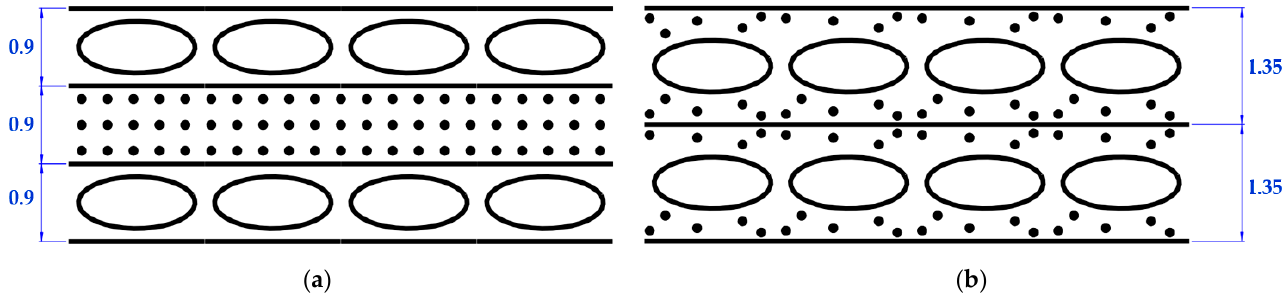
Figure 11. Breaker layer calculation schemes: ( a ) by identifying the intermediate rubber layer and ( b ) without identifying the intermediate rubber layer.